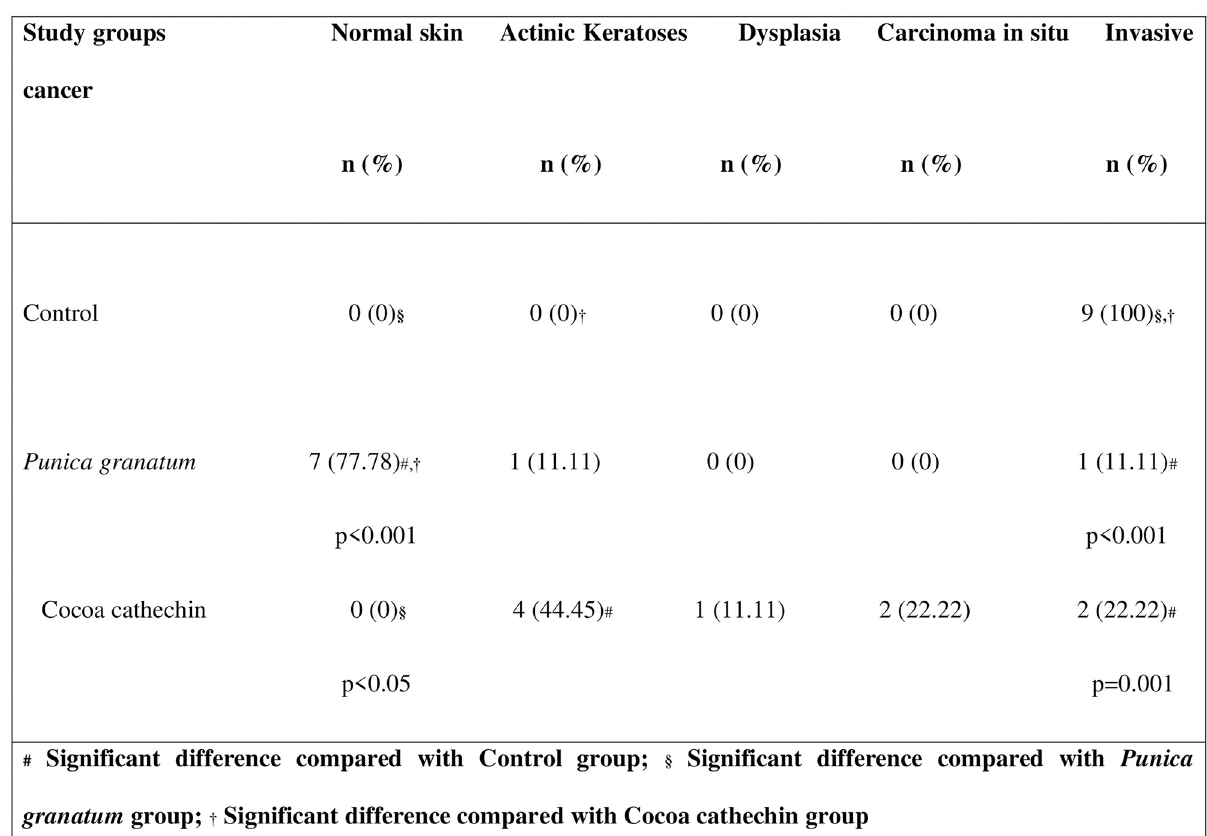
Fig 1. Table of comparison of incidence of skin lesions between study groups (Pearson’s χ 2 test).